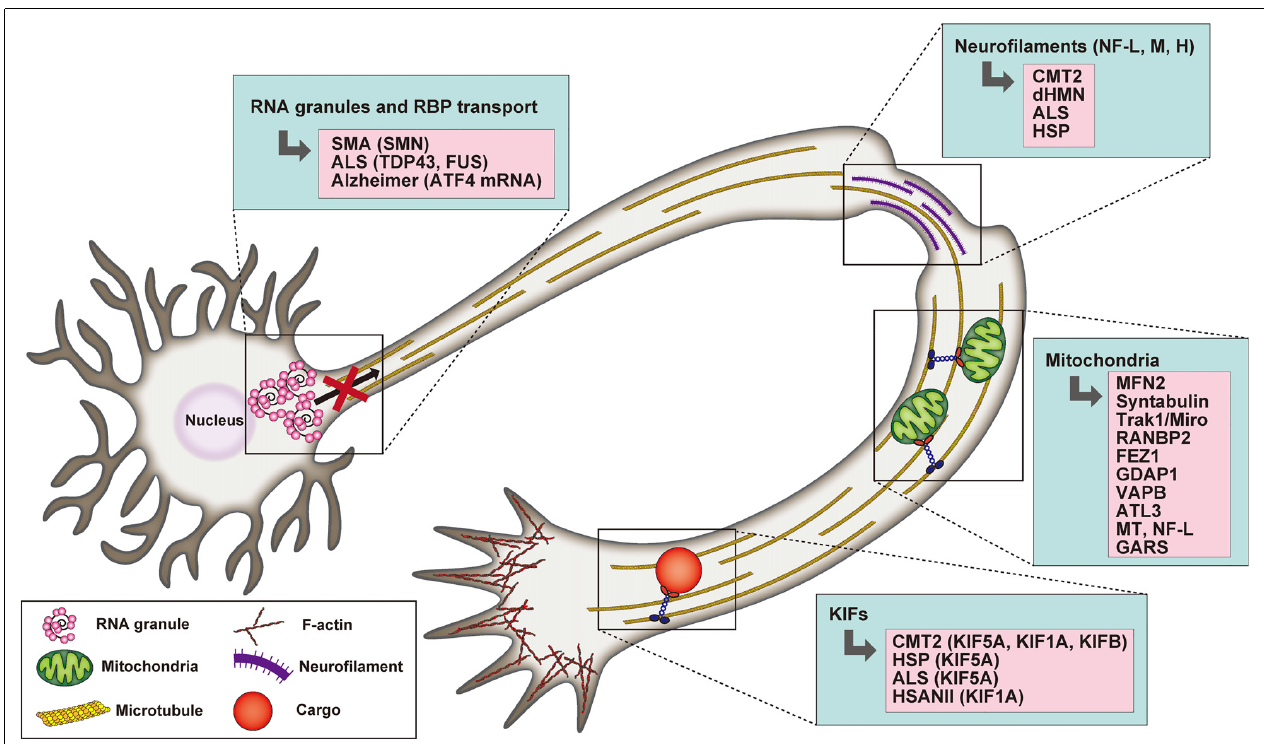
FIGURE 2 | Schematic representation highlighting the association between RNA granule transport, neurofilaments (NFs), mitochondria, and kinesin motors with selected neuronal degenerative diseases. In the case of mitochondria defects, the mutated proteins underlying neurodegeneration are